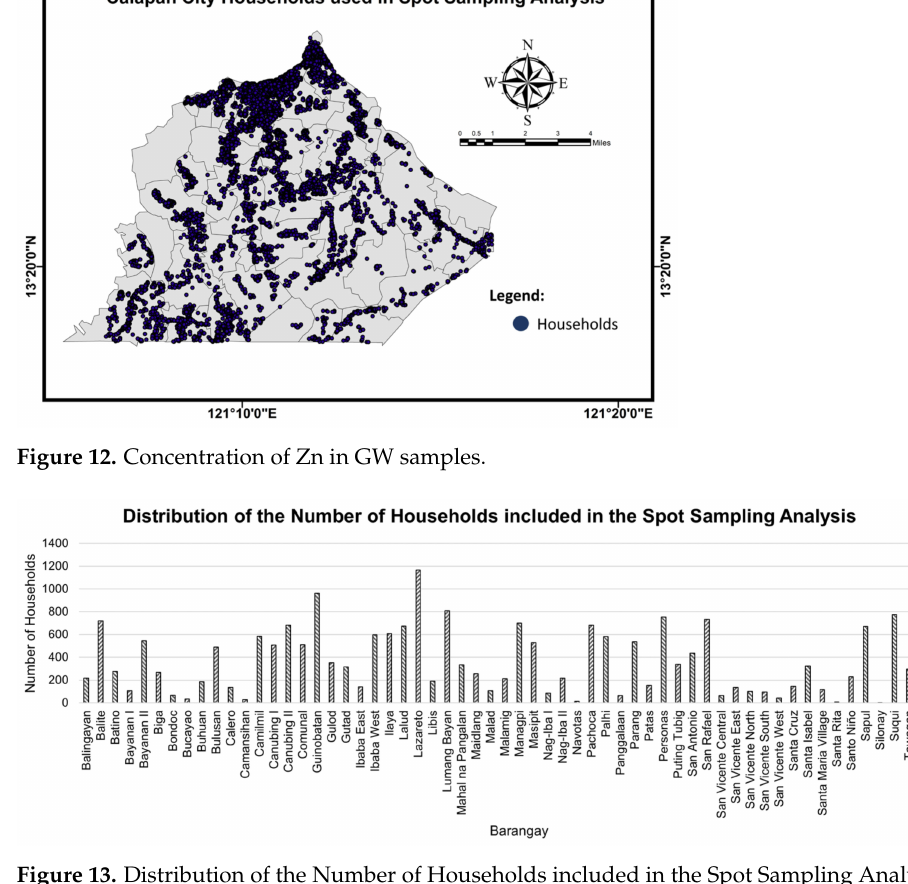
Figure 13. Distribution of the Number of Households included in the Spot Sampling Analysis.